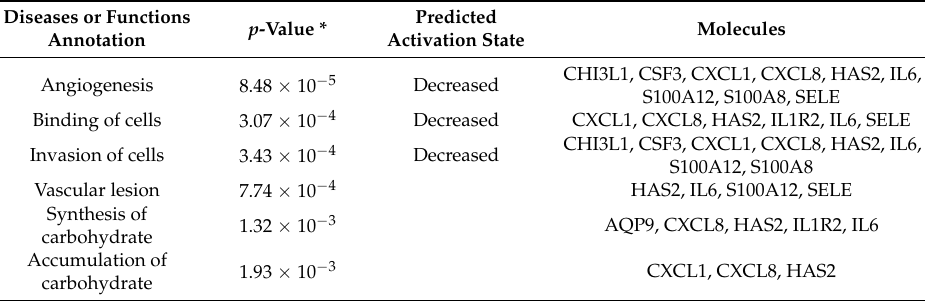
Table 3. Pathways involved in the transcriptional regulation of varicose veins